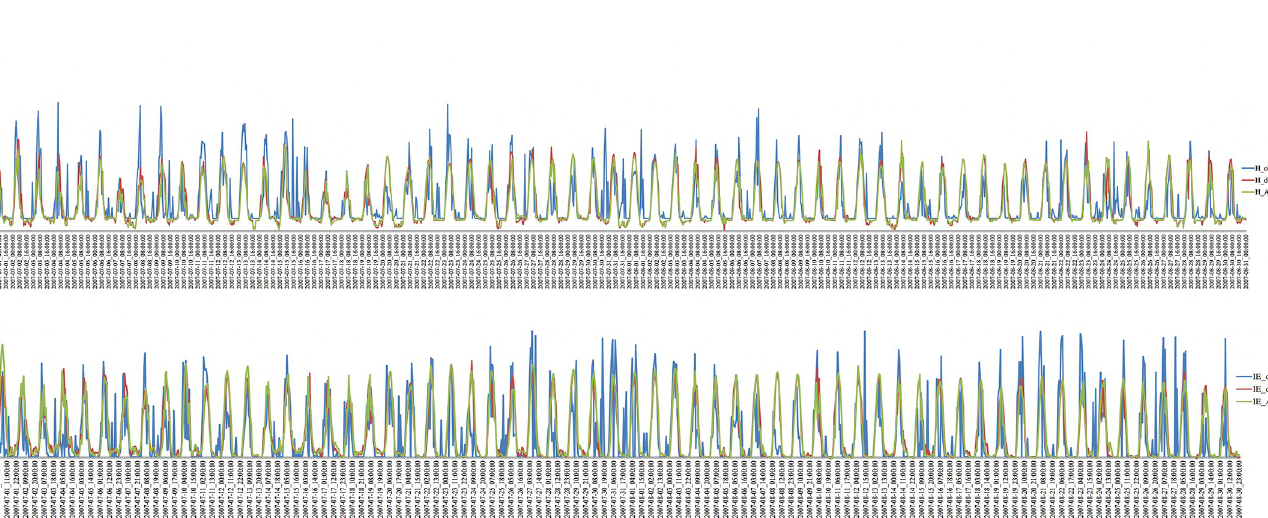
PLOS ONE | https://doi.org/10.1371/journal.pone.0226373 December16, 2019 8 /